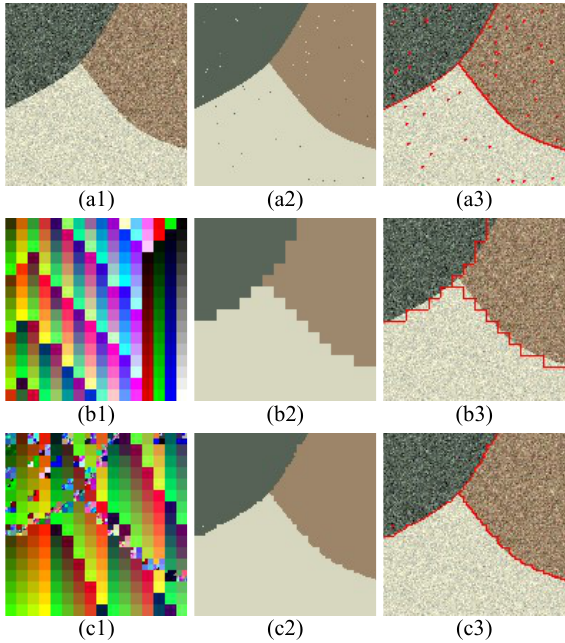
Figure 3. Simulated image and its segmentation results. (a1) simulated image, (a2)-(a3) HMRF-FCM, (b1)-(b3) RT- HMRF-FCM, (c1)-(c3) The proposed algorithm To further demonstrate the applicability of the proposed algorithm, a lot of multi-spectral remote sensing images are also tested. The representative ones are shown in Figures 4 and 5. Figure 4(a1) is SPOT images, Figure 5(a1) is IKONOS image, Figure 4,5 (a2) and (a3) are the segmentation result and the outline overlay image of HMRF-FCM, Figure 4,5(b1)-(b3)